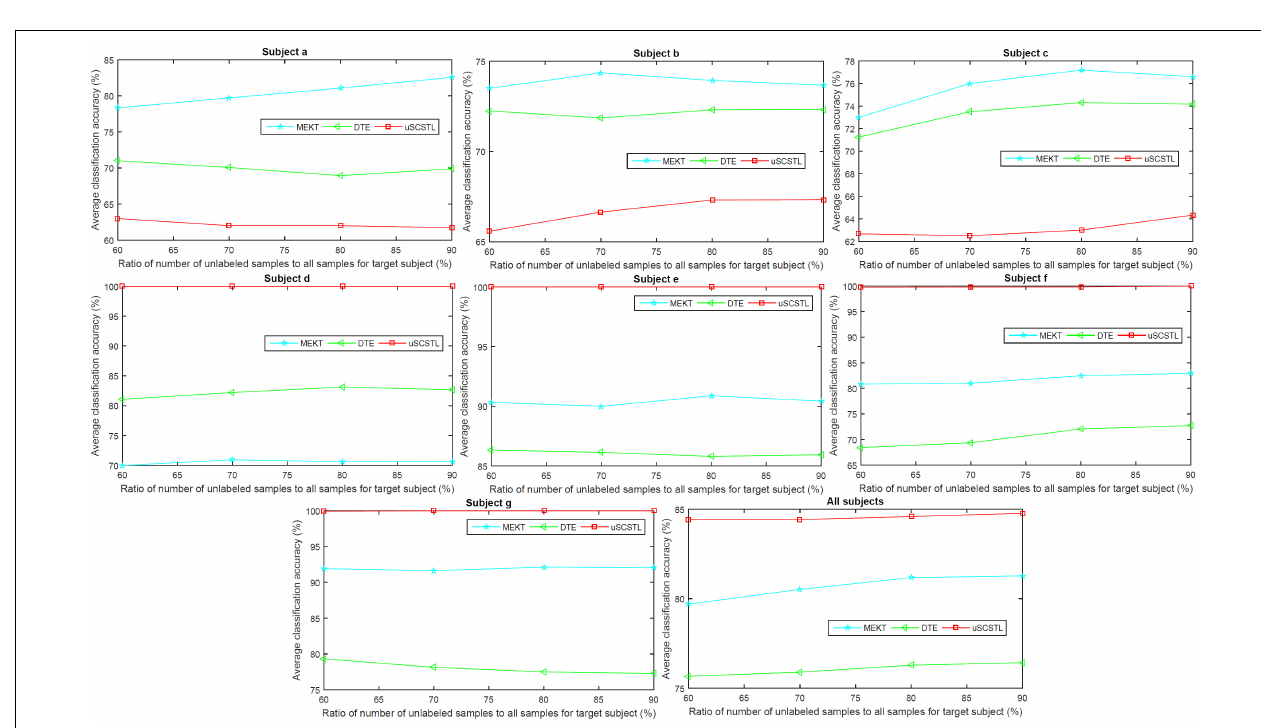
FIGURE 7 | Average classification accuracies of all subjects on dataset MI2, and their means, with varying R u , for unsupervised algorithms.